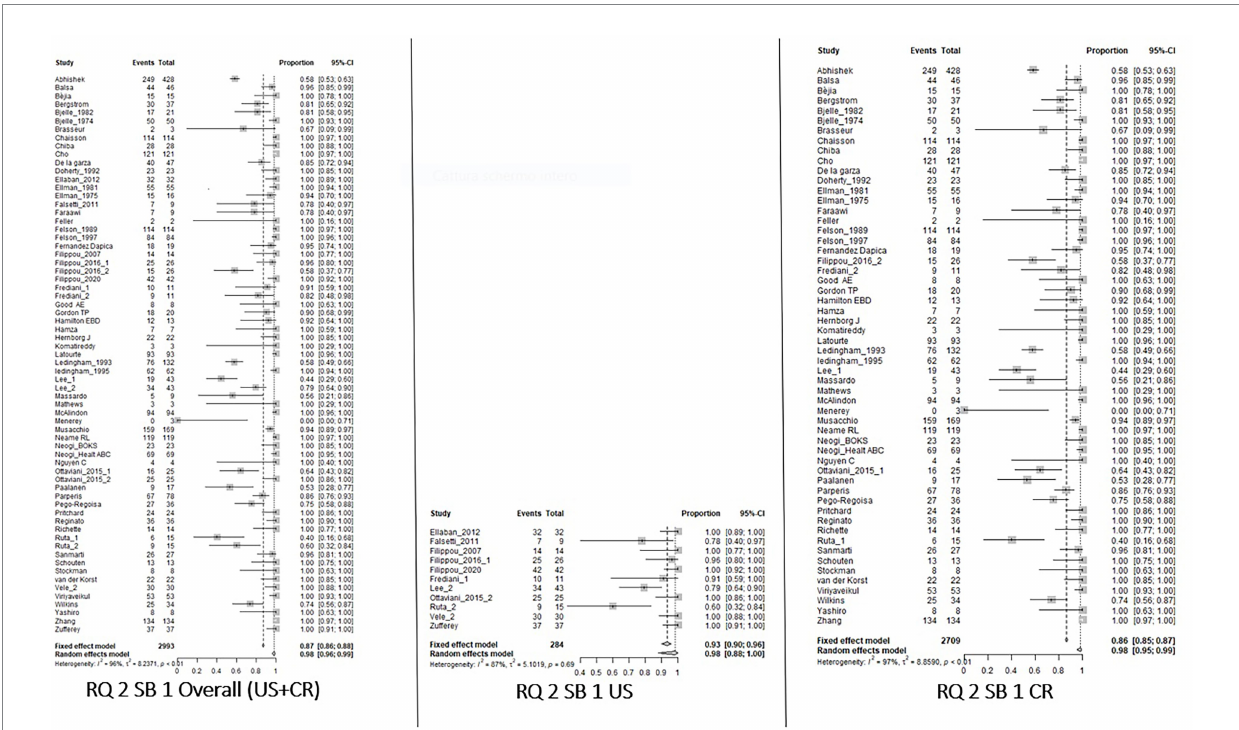
FIGURE 3 Forest Plot Knee, Research Question 2 (RQ 2), Sub_analysis 1: patients with suspected CPPD and the knee joint used as index joint, independently of the reference standard used for diagnosis, analyzed by